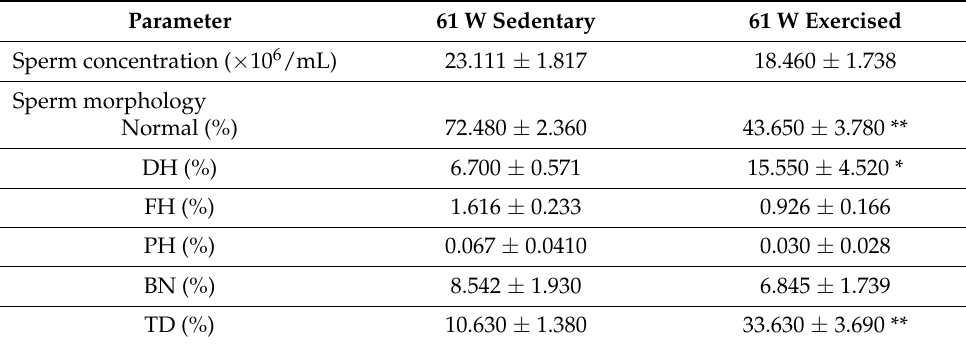
Table 2. Influence of exercise training on rat’s sperm concentration and morphology. The results are expressed as the mean ± SEM. * p < 0.05; ** p < 0.01. N, normal; DH, decapitated head; FH, flattened head; PH, pin head; BN, bent neck; TD, tail defect. Parameter 61 W Sedentary 61 W Exercised Sperm concentration ( × 10 6 /mL) Sperm